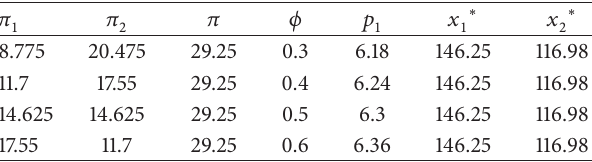
Table 2: Outcomes in the incentive model under the guidance of the